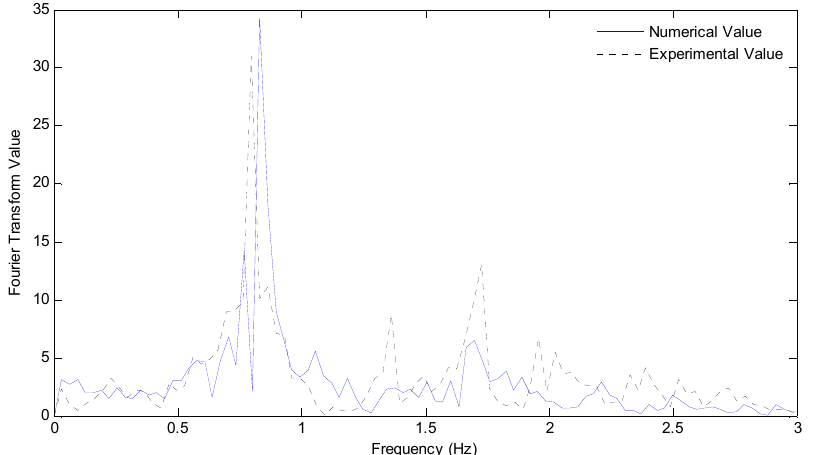
Figure 10. Comparison of Fourier transformations of the experimental and numerical values of water elevation at the corner of the tank excited by the N-S component of the El Centro earthquake at a 0° orientation.